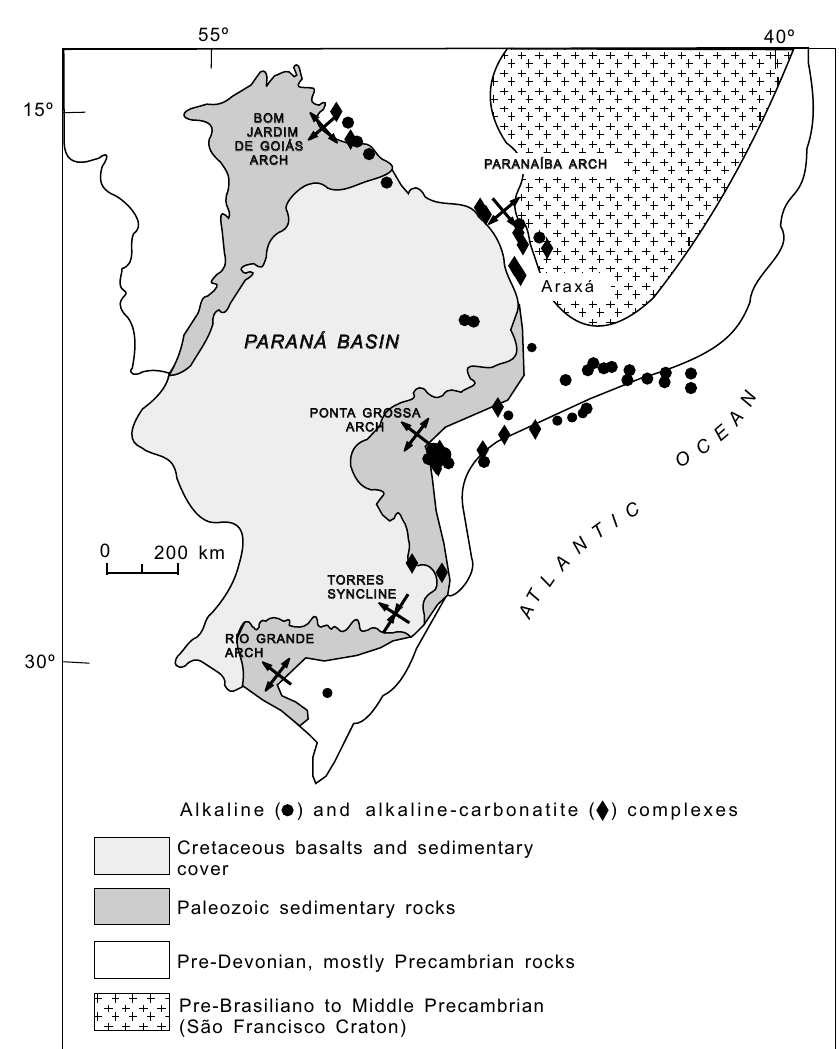
Fig. 1 – Alkaline and alkaline-carbonatite occurrences of southern Brazil (after Ulbrich & Gomes 1981 simplified). The Araxá complex is also